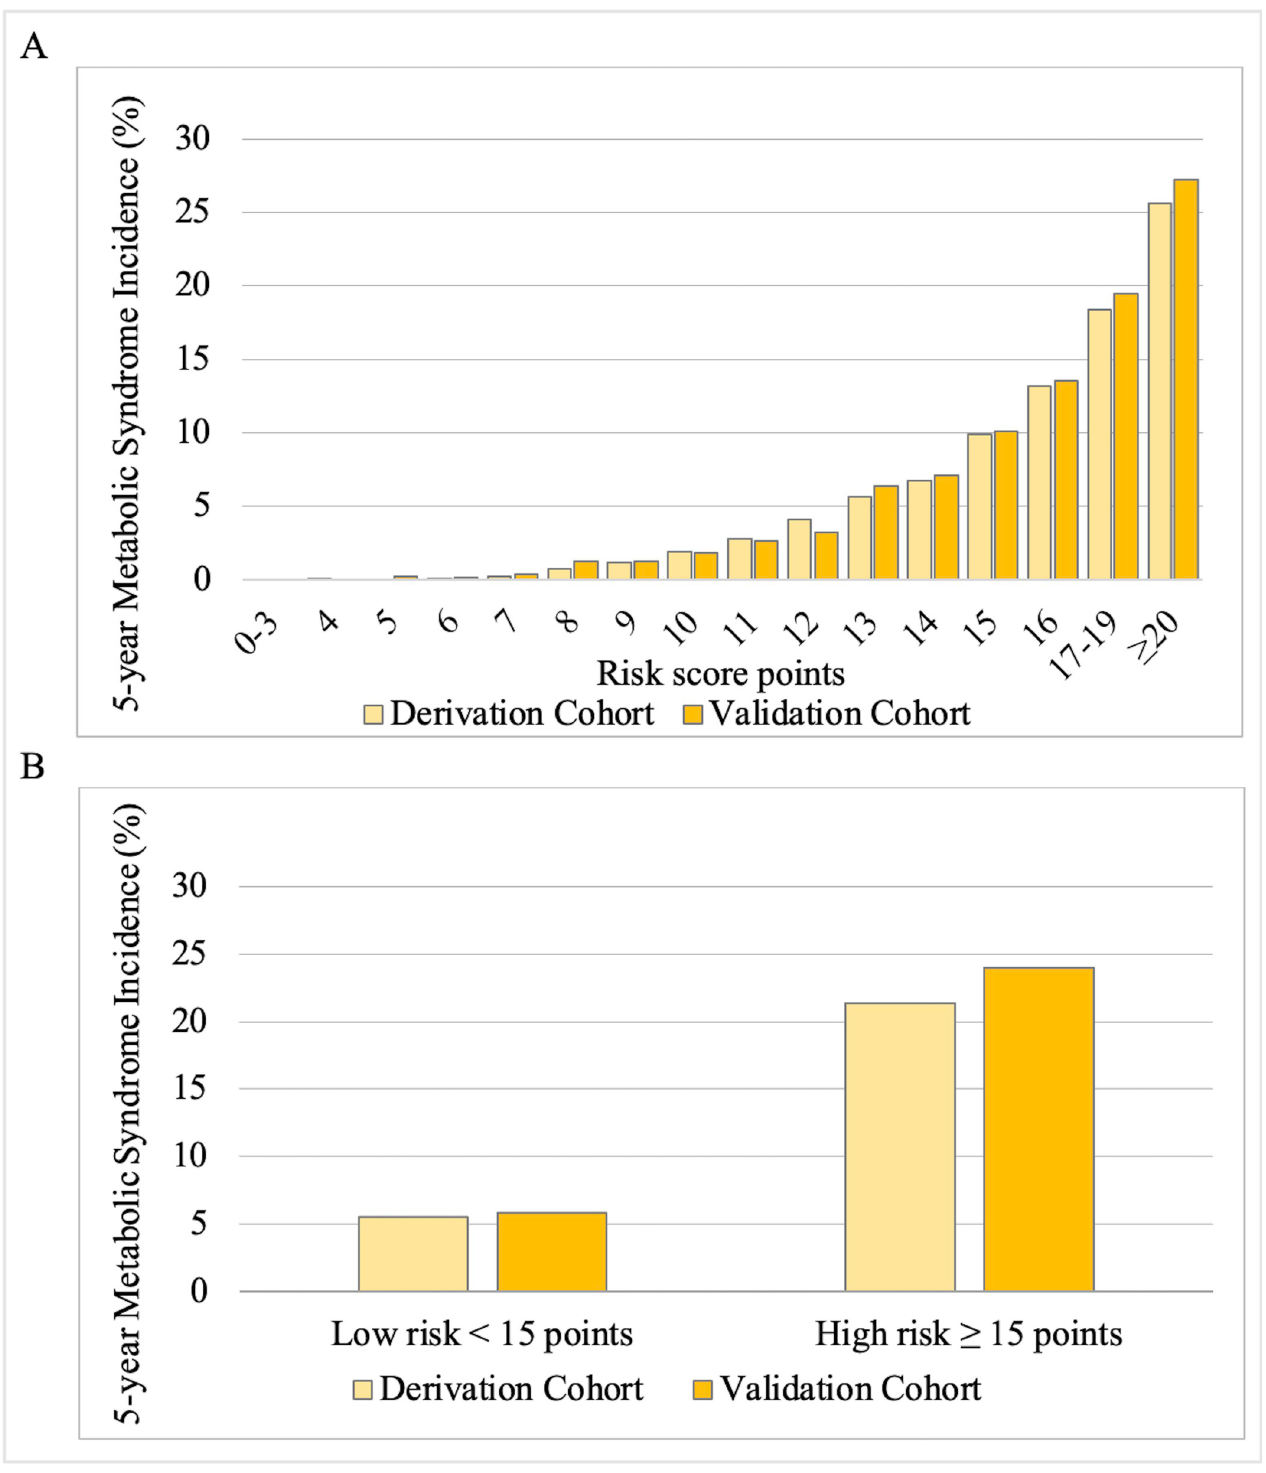
Fig 3. Proportions of metabolic syndrome in the primary and simple score model (excluding blood tests) in derivation and validation cohorts. Incidence of 5-year MetS according to the score in the derivation and validation cohort expressed in a bar graph. A. Primary score B. Simple risk score.